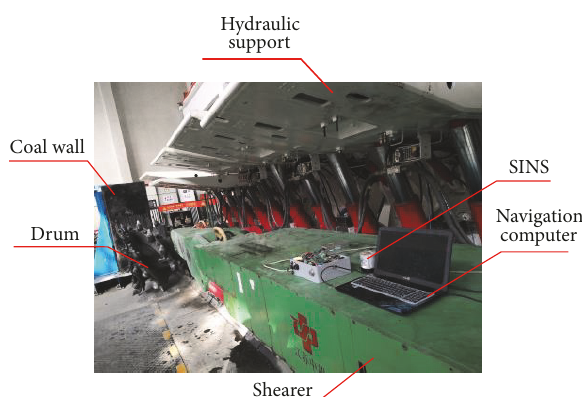
Figure 5: Shearer mounted strap-down inertial navigation system in this